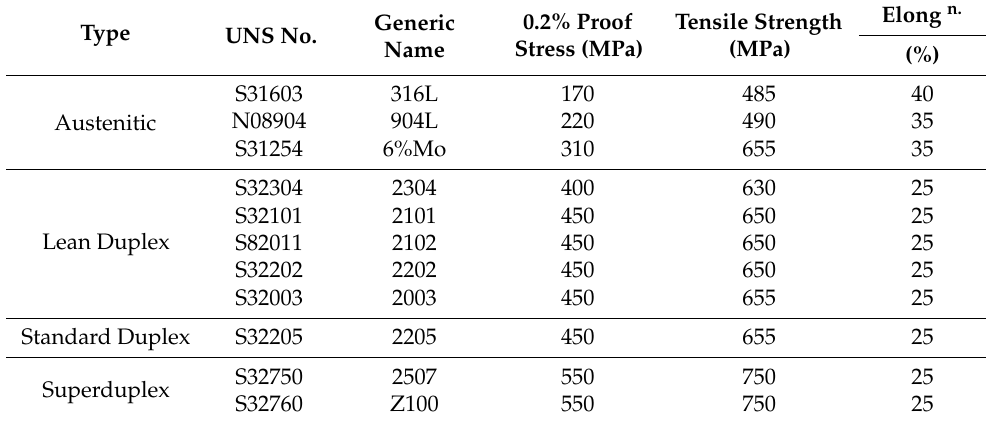
Table 3. Minimum mechanical properties of some common wrought stainless steels at room tempera- ture. Elong n. :